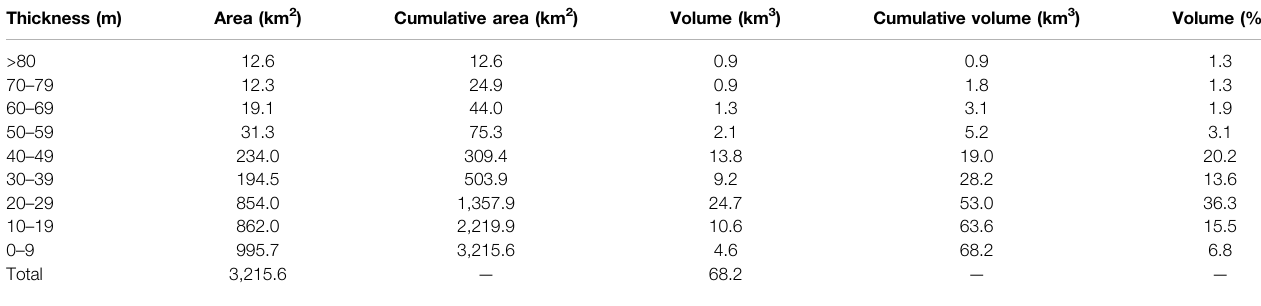
TABLE 2 | The values of thickness (m), area (km 2 ), cumulative area (km 2 ), volume (km 3 ), cumulative volume (km 3 ) and the percentage of volume for each isopach. Thickness